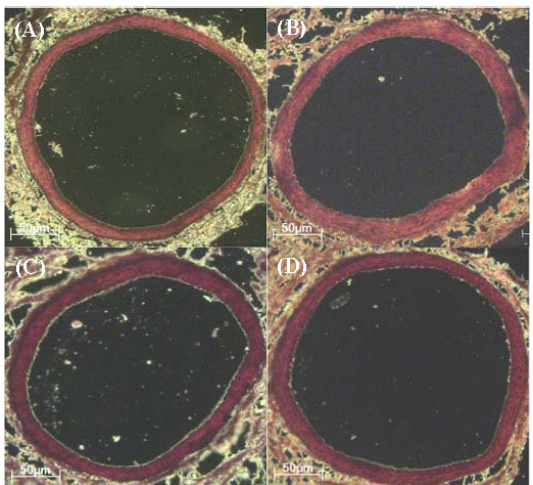
Figure 2. Abdominal aortic wall thickness and lumen diameter taken at eight weeks, pertaining to